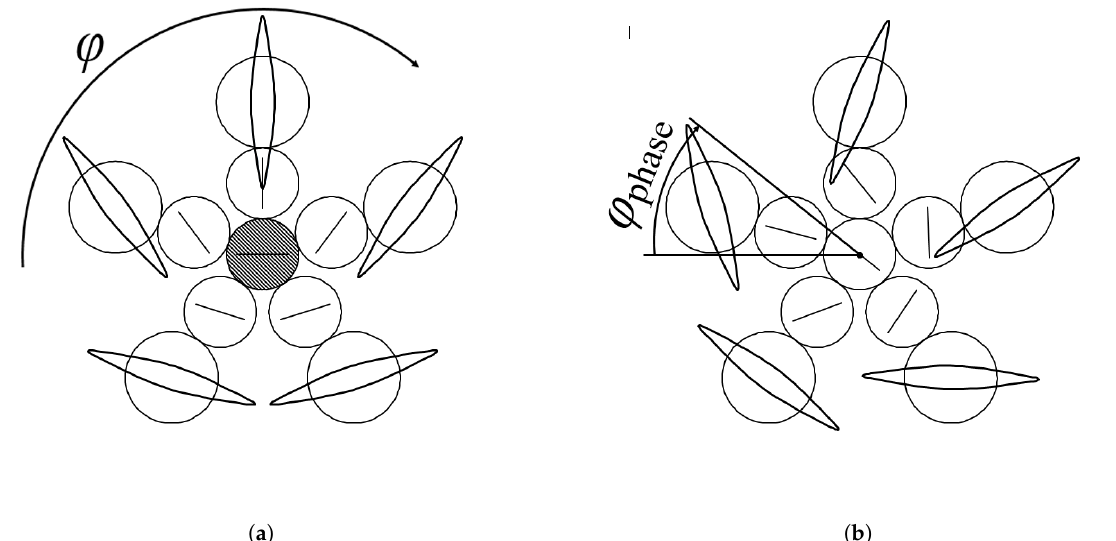
Figure 2. The turbine can be adjusted to the flow direction. ( a ) Kinematics of the planetary gearbox with a static central gear. The transmission ratio is 2:1. ( b ) Phase angle affected by the central gear